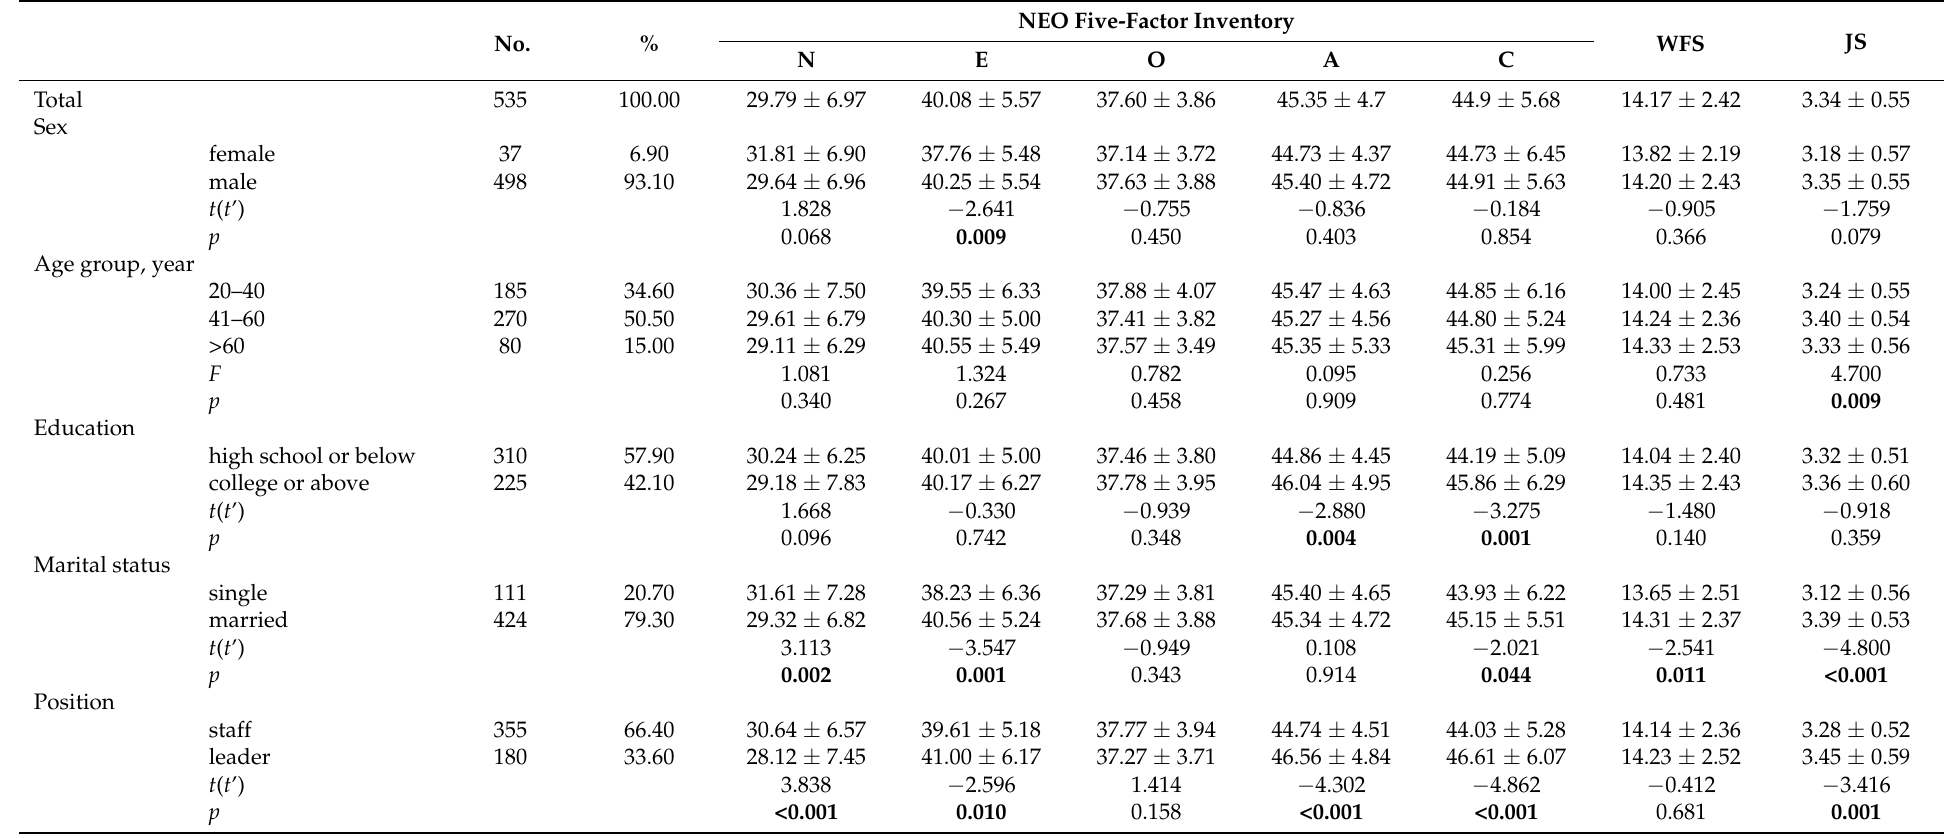
Table 2. Demographic characteristics and scores of the participants (mean ± standard